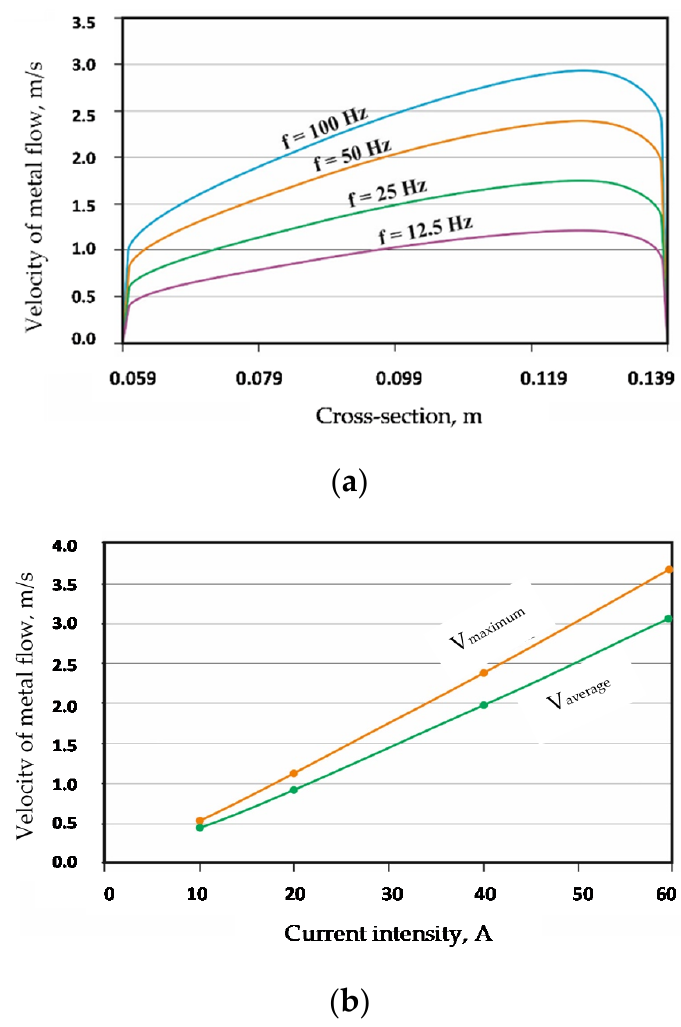
Figure 4. ( a ) Influence of frequency on the metal flow velocity for the cross-section when current intensity is 40 A; ( b ) relation between metal flow velocity and current intensity for frequency 50 Hz.